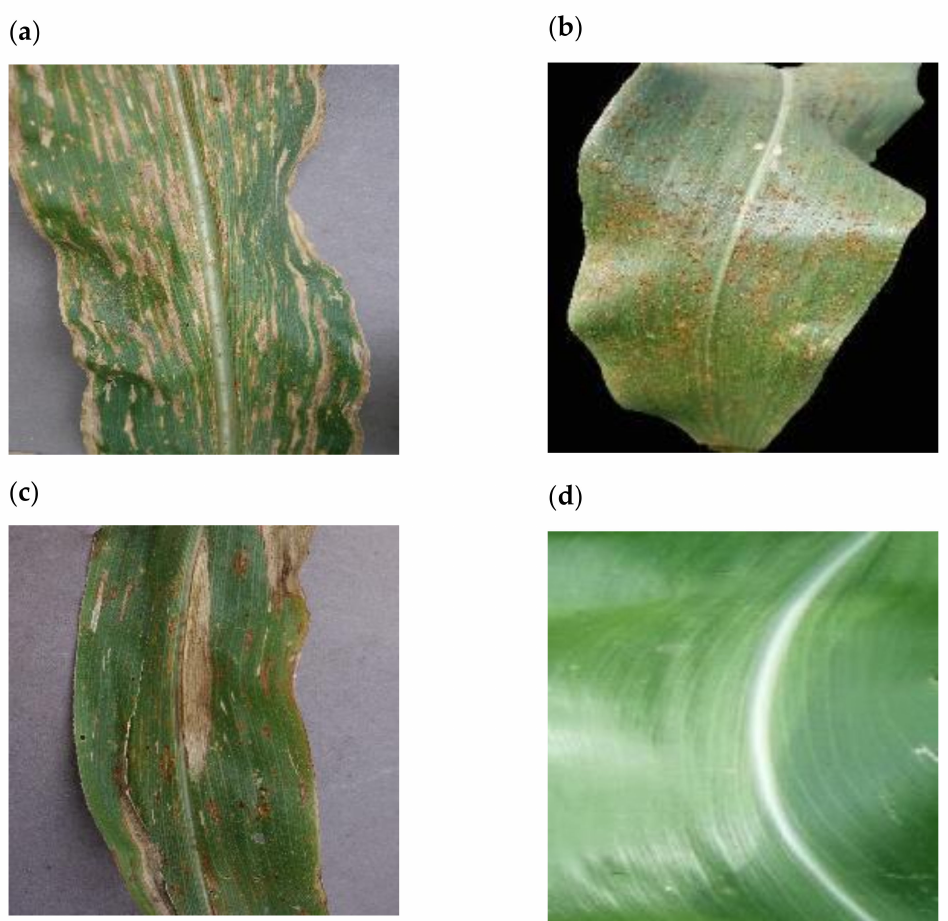
Figure 1. Images of maize leaves obtained from PlantVillage. ( a ) Image labelled as GLS positive. ( b ) Image labelled as CR positive, note the presence of Phaeosphaeria Leaf Spot (PLS). ( c ) Image labelled as NCLB positive, note the presence of CR. ( d ) Image labelled as